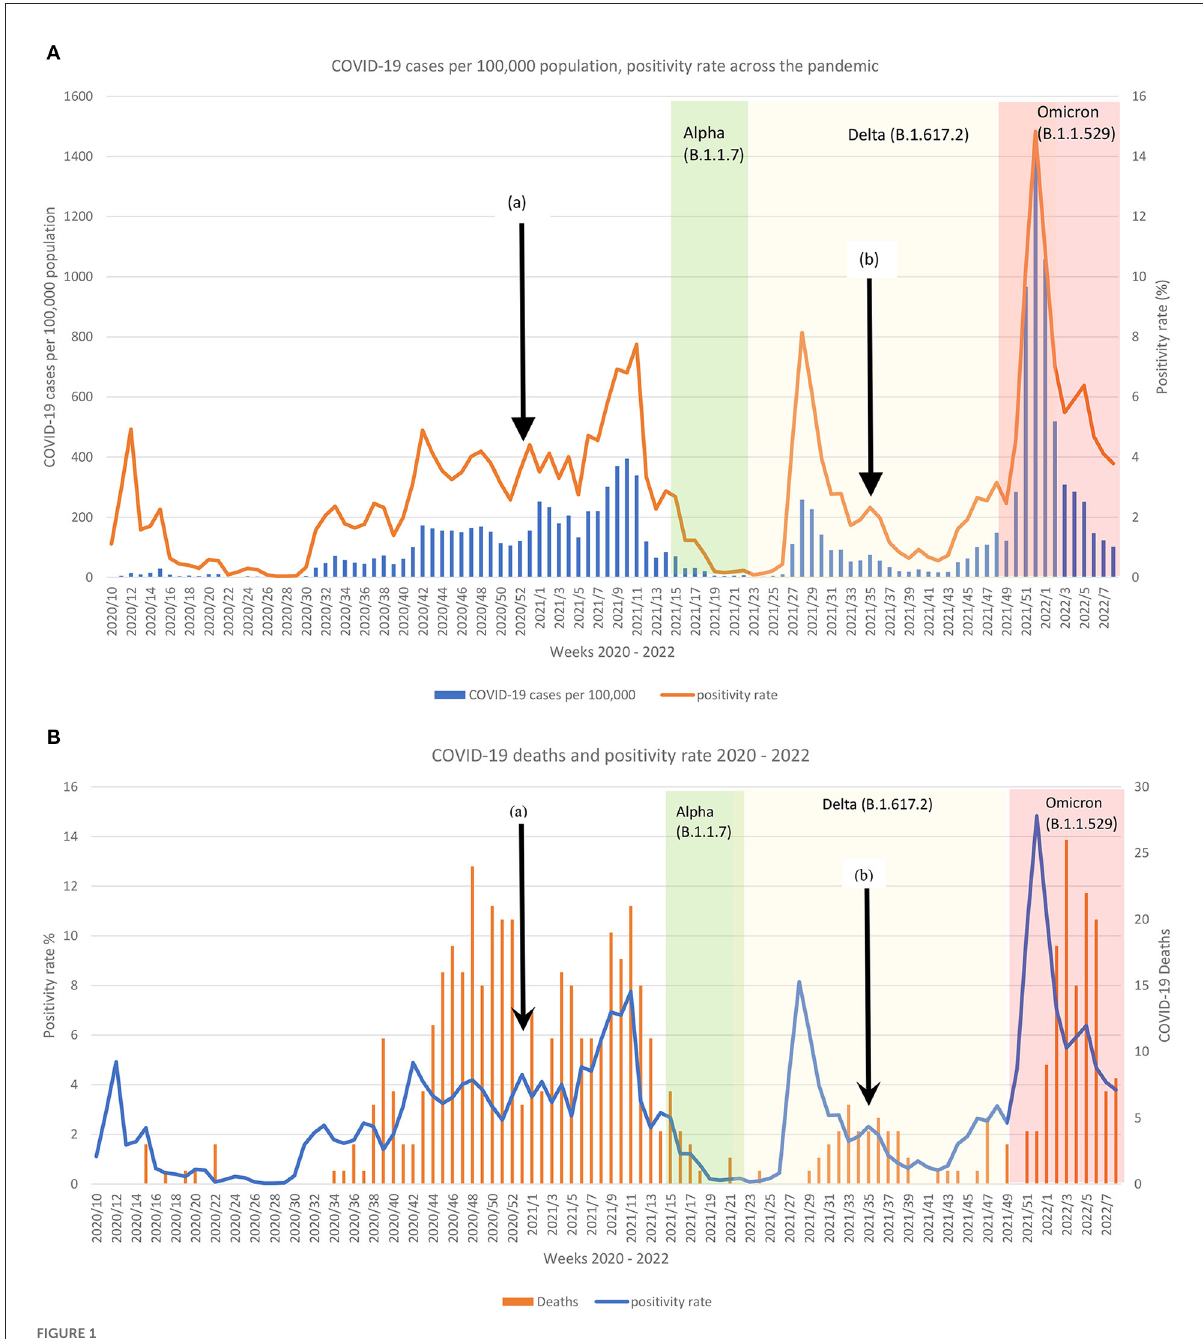
FIGURE1 Comparison of the reported (A) COVID-19 cases per 100,000 and positivity rate per week and (B) COVID-19 deaths and positivity rate per week according to the dominating variant across 2 years in Malta. Black arrow (a) indicates start of COVID-19 vaccination and (b) start of booster dose. White background = original SARS-CoV2; Green background = Alpha variant; Yellow background = Delta variant; Red background = Omicron